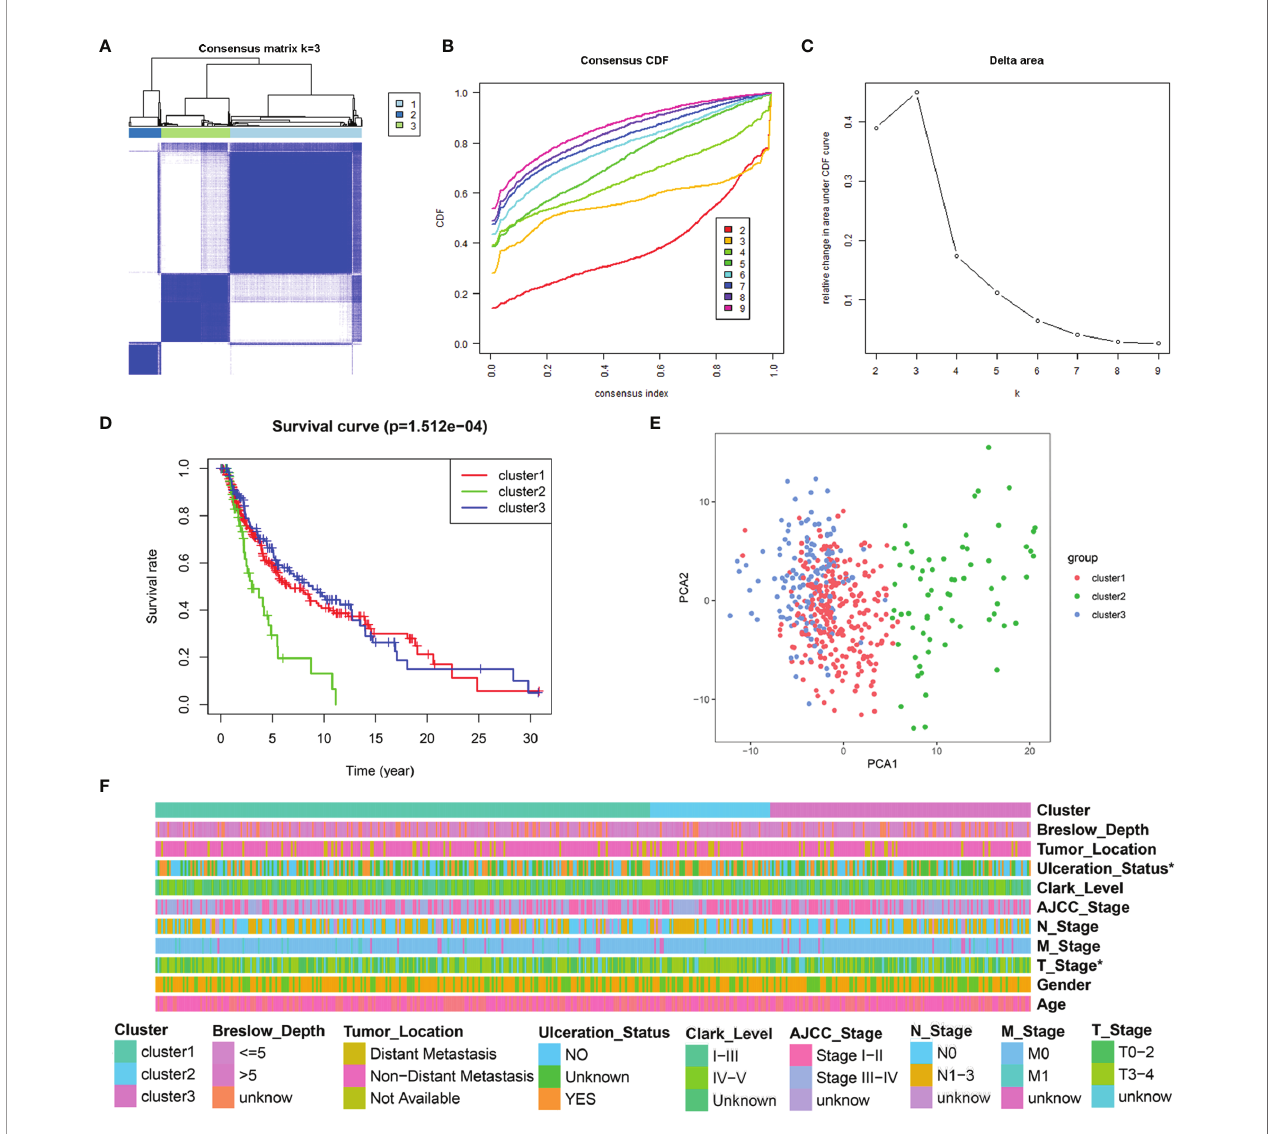
FIGURE 3 | Consensus clustering analysis of 184 LRGs. (A) Consensus clustering matrix at K = 3. (B) The CDF curves for clusters at k = 2 to 9. (C) The relative change in area under CDF curves for different clusters from k = 2 to 9. (D) Survival analysis for SKCM samples is strati fi ed to the three clusters. (E) PCA plot for the three clusters. (F) Heatmap and the clinical parameters of the three clusters. * P <